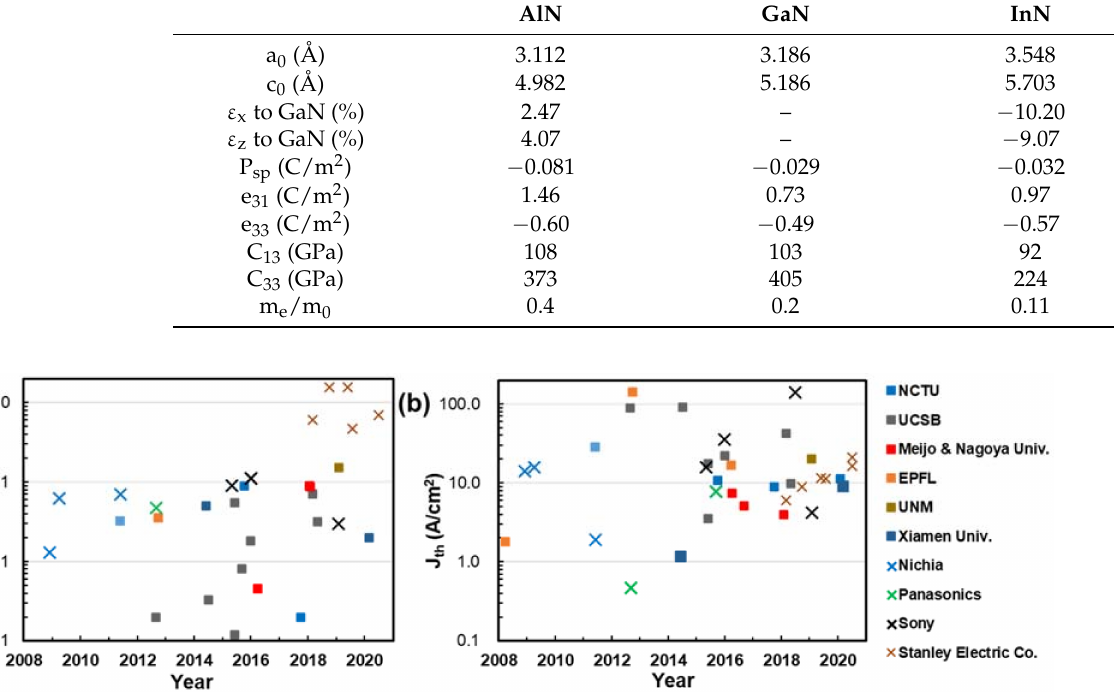
Table 1. The lattice constant, spontaneous polarization, piezoelectric tensor elements, elastic con- stant, electron effective masses, and of wurtzite nitride materials. Parameters collected from refer- ences [13–17].